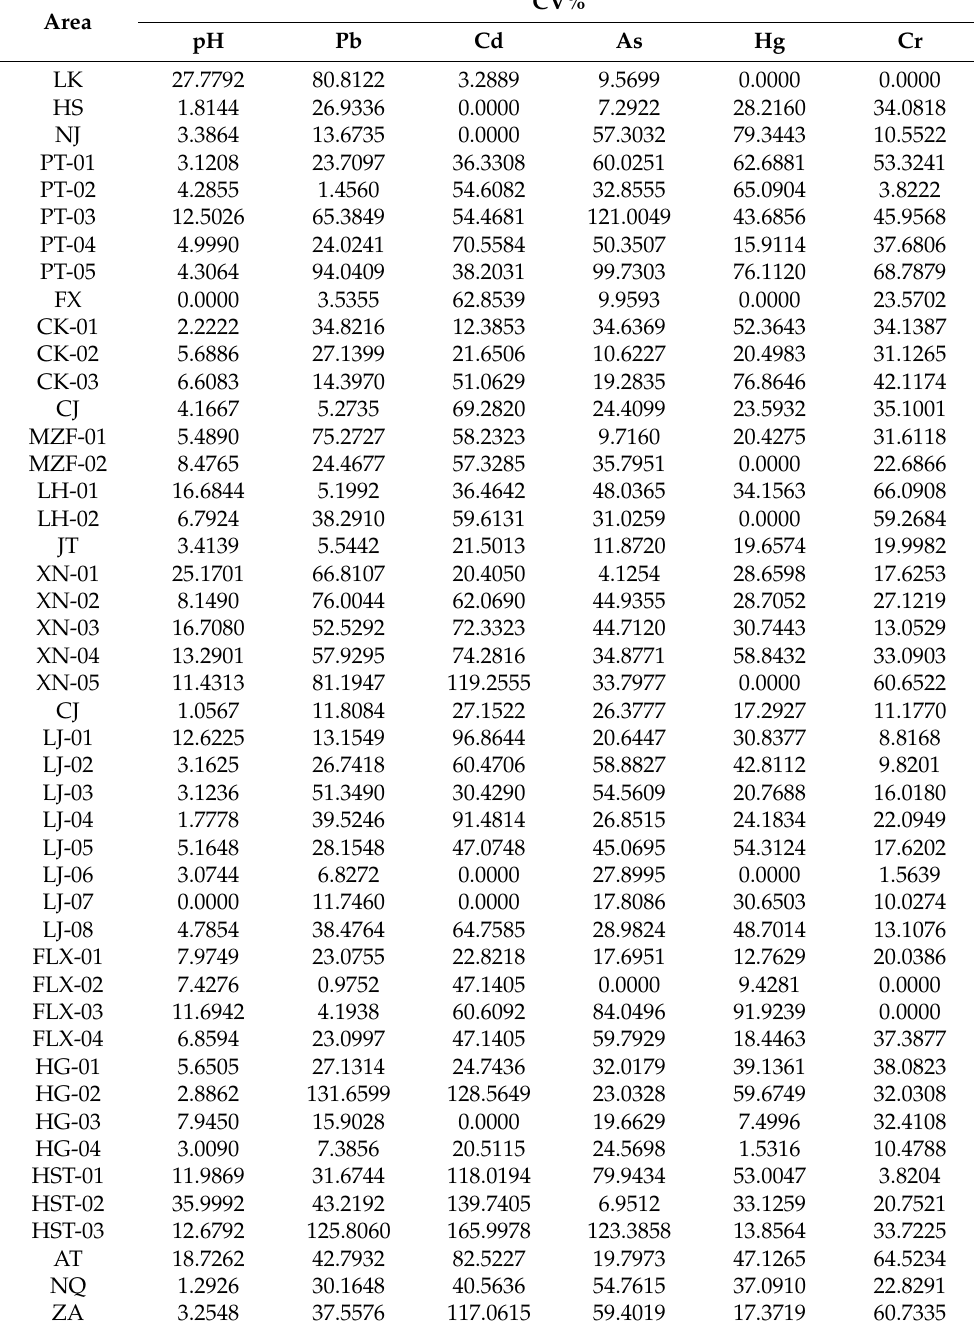
Table 2. Coefficient of variation of heavy metal content in different